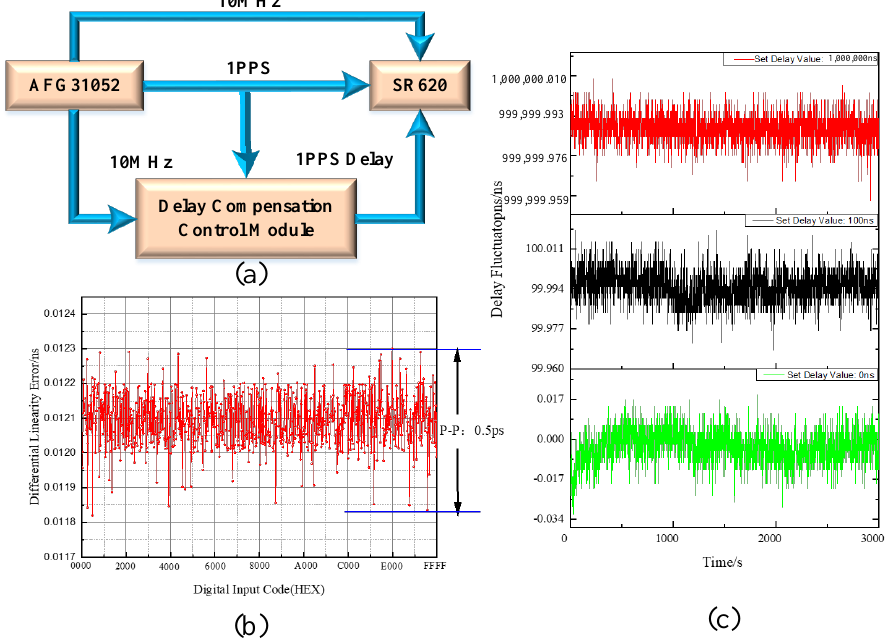
Figure 3. ( a ) Test diagram of the delay compensation control module; ( b ) Differential linearity error vs. code; ( c ) Delay fluctuations of the delay compensation control